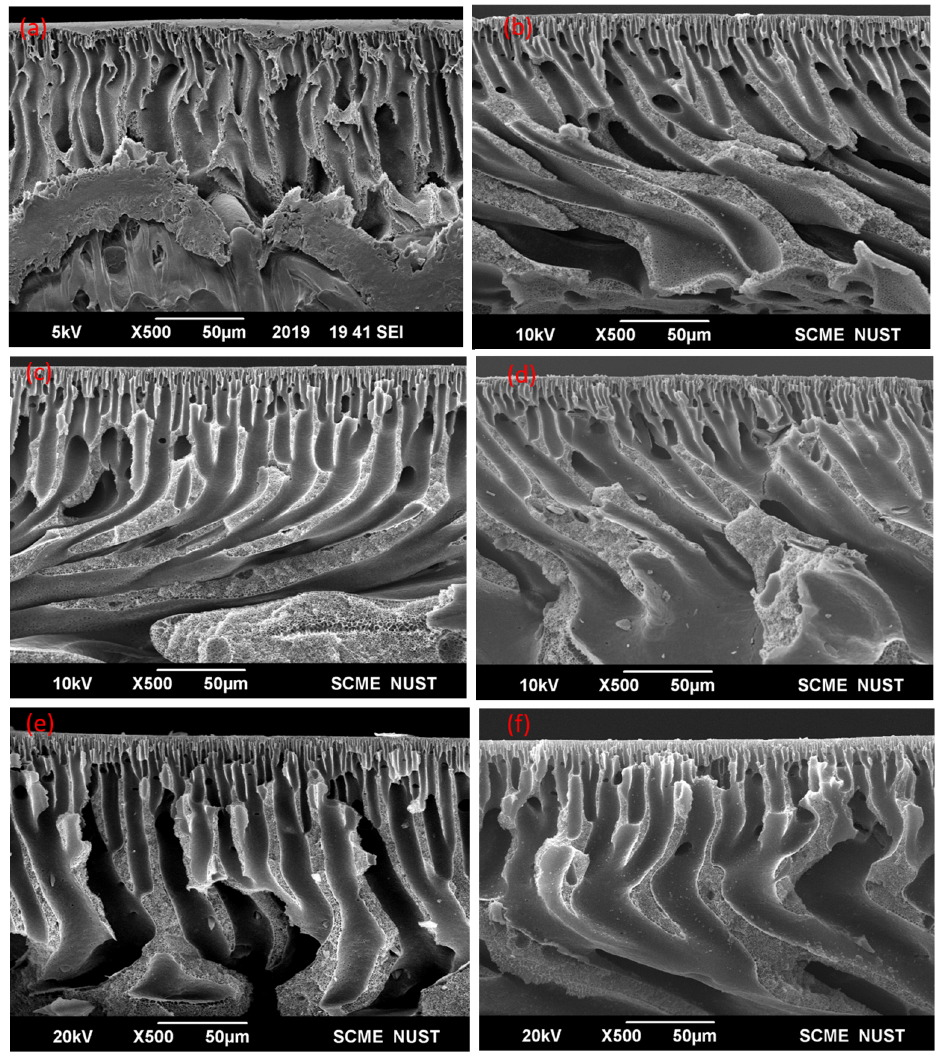
Figure 4. Cross-sectional SEM micrographs for 20% wt. membranes where ( a ) P 0 , ( b ) PP, ( c ) PPC, ( d ) PPAC, ( e ) PPCAC and ( f ) PPTCAC.